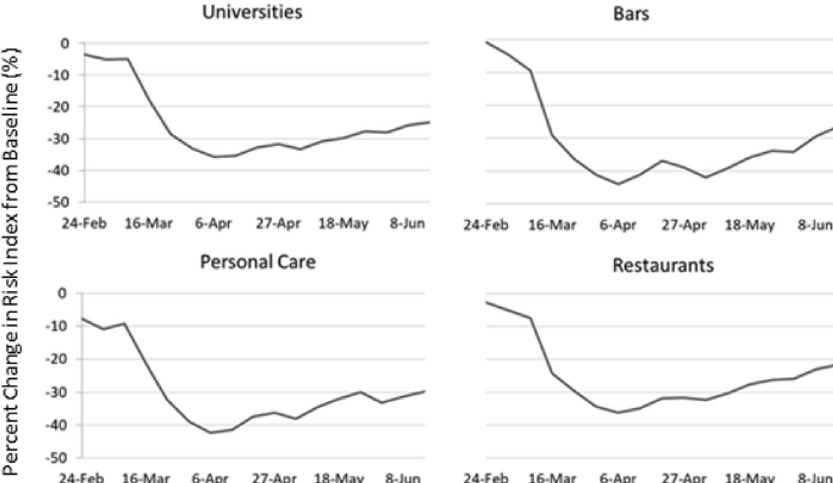
Fig. 3 Percent change in Business Risk Index by industry. Percent change in Business Risk Index by types of potential high-risk industries over time from January 2020 to June